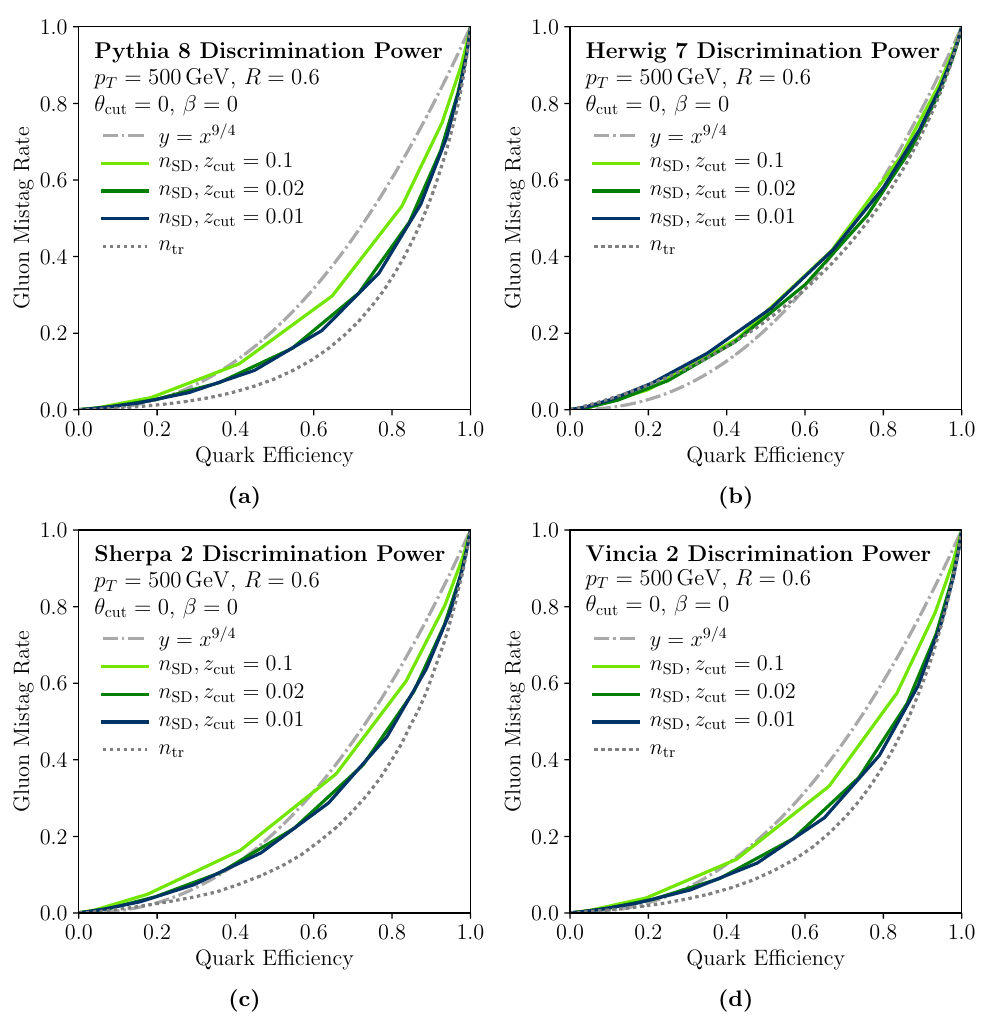
Figure 15. Same as (cid:12)gure 13, but for the collinear-unsafe soft drop multiplicity with (cid:18) (cid:12) =